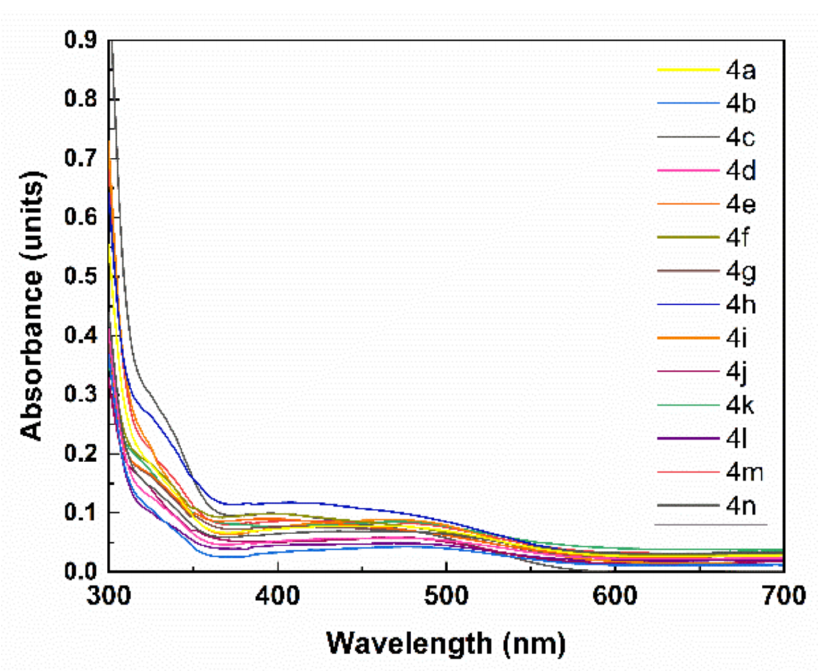
Figure 6. UV-vis absorption spectra of benzyl pyrazolyl naphthoquinones in DMSO. Comparison of the Catalytic Efficiency of MSMF with Various Catalysts Reported for the Synthesis of Benzyl Pyrazolyl Naphthoquinones: To show the efficiency of